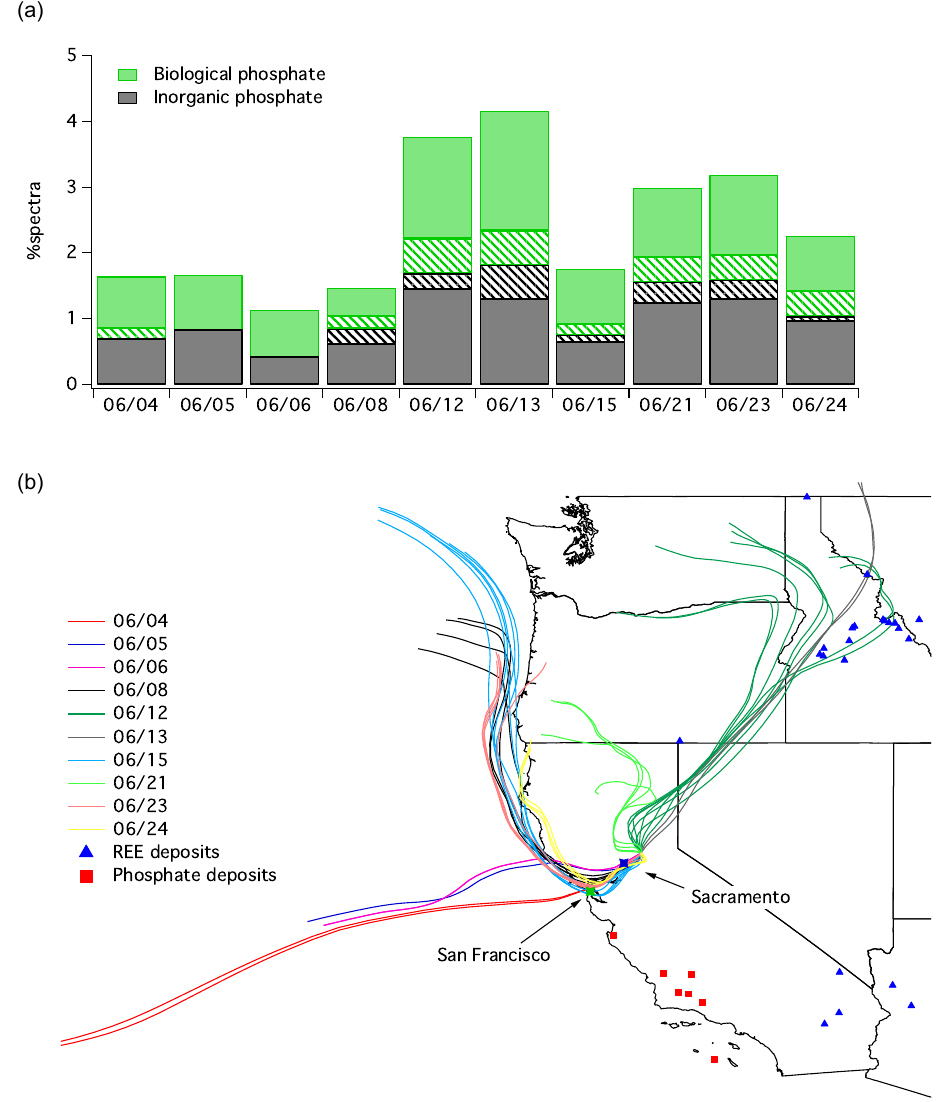
Figure 7. (a) The percentage of ambient aerosol particles from the CARES dataset categorized as biological and inorganic (phosphate- bearing mineral dust or fly ash) phosphate using the criteria developed in this work. Hatched regions indicate uncertain assignments per the boundaries in Fig. 5. (b) HYSPLIT back trajectories plotted for 10 measurement days at the Cool, CA, site. Locations of REE, phosphate and carobonatite deposits, sourced from US Geological Survey, are co-plotted (Berger et al., 2009; Chernoff and Orris, 2002; Orris and Grauch, 2002) along with locations of major urban centers. Dates are given as